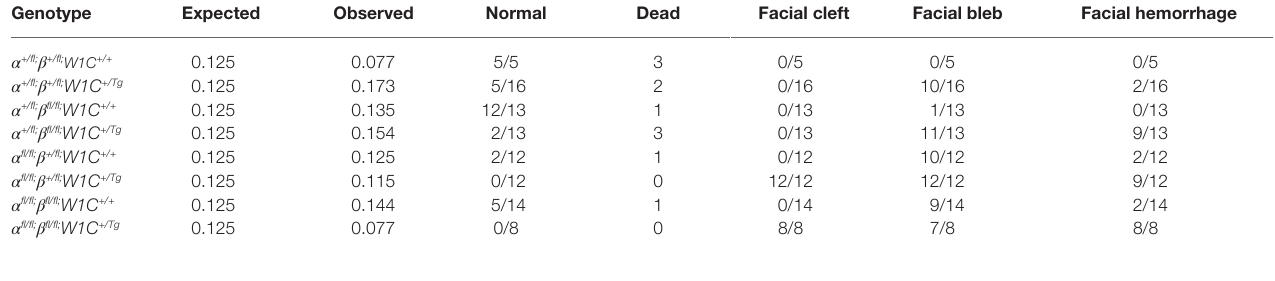
TABLE 2 | Phenotypes of E13.5 embryos from intercrosses of Pdgfra fl/fl ; Pdgfrb fl/fl mice with Pdgfra +/fl ; Pdgfrb +/fl ; Wnt1-Cre +/Tg mice. Genotype Expected Observed